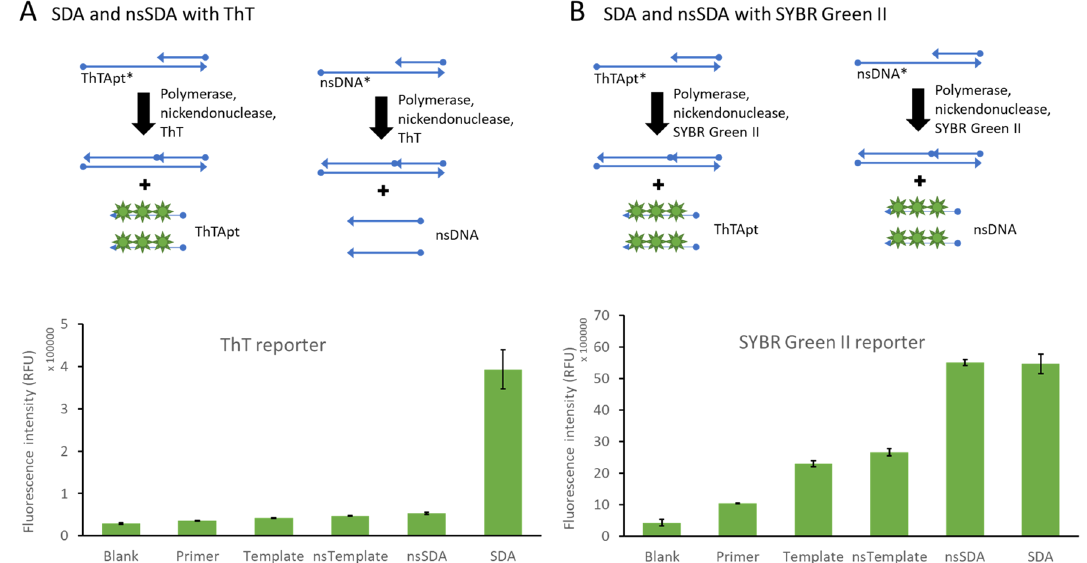
Figure 6. Strand displacement amplification (SDA) product specificity. ( A ) A schematic diagram (top) shows how SDA (aptamer product) and nsSDA (nonspecificSDA; SDA with the non-aptamer product) react in ThT. A bar graph shows fluorescence intensity (RFU) at 50 min with necessary controls (bottom). ( B ) A schematic diagram (top) shows how SDA and nsSDA react in SYBR Green II. A bar graph shows fluorescence intensity (RFU) at 50 min with necessary controls (bottom). Error bars represent the standard deviation of triplicate measurements in all